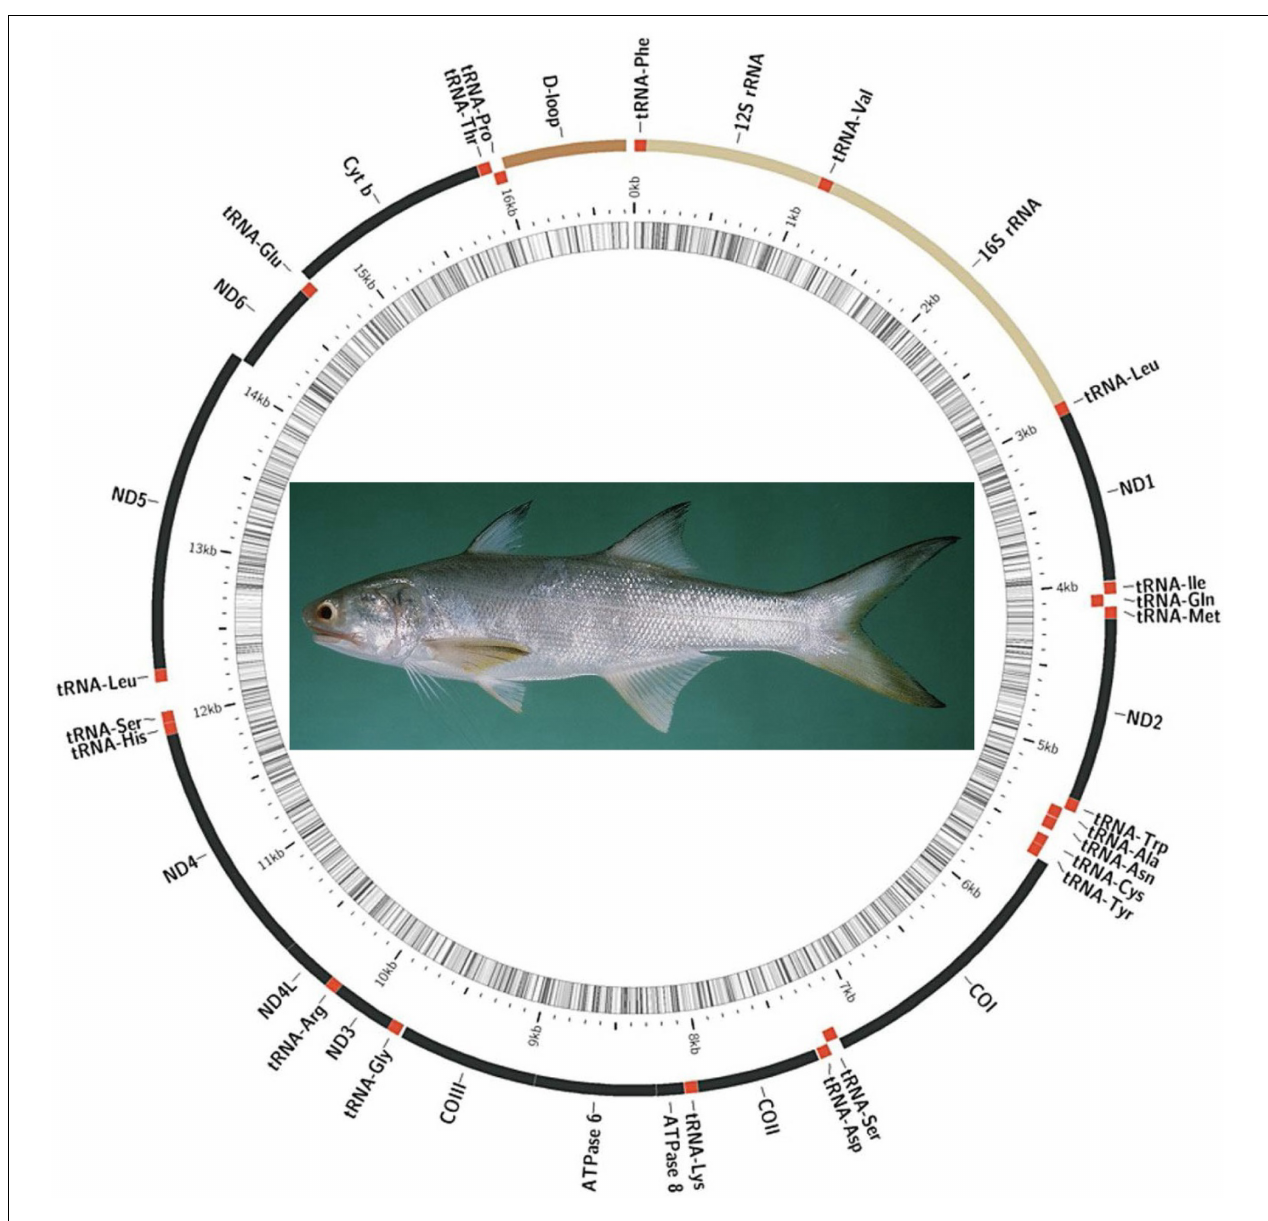
FIGURE 1 | Gene map of the Eleutheronema rhadinum mitochondrial genome.